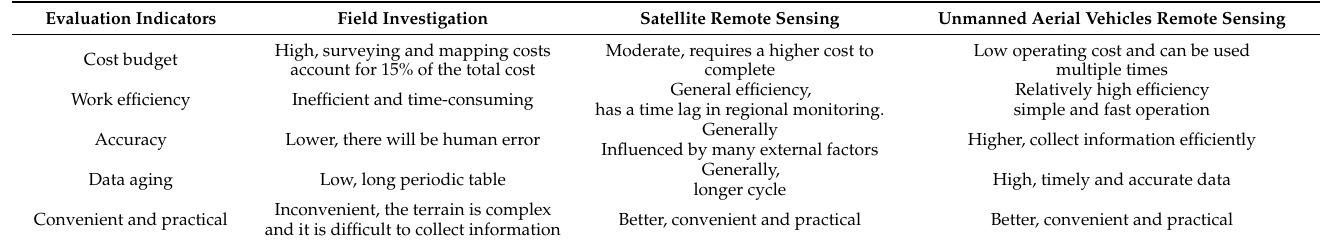
Table 3. A comparison of field investigation, satellite remote sensing, and unmanned aerial vehicle remote sensing